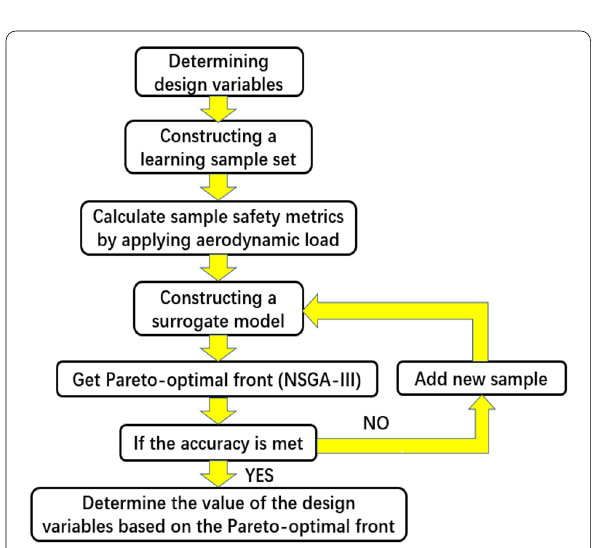
Figure 15 Process of